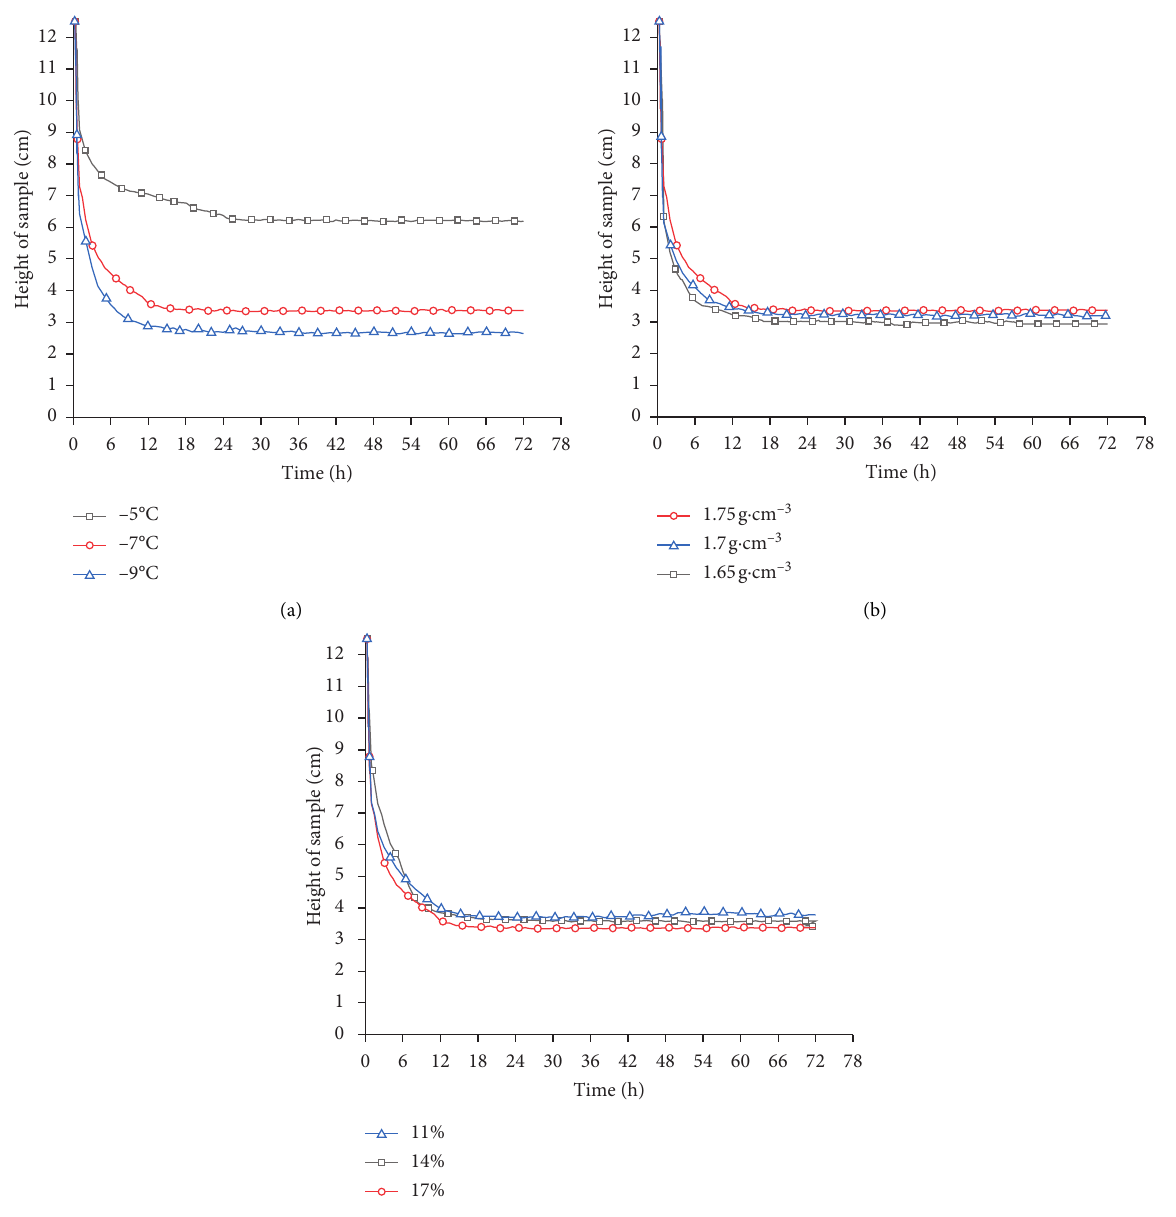
Figure 6: Freezing depths of soil samples under (a) different top-plate temperatures, (b) dry densities, and (c) initial moisture